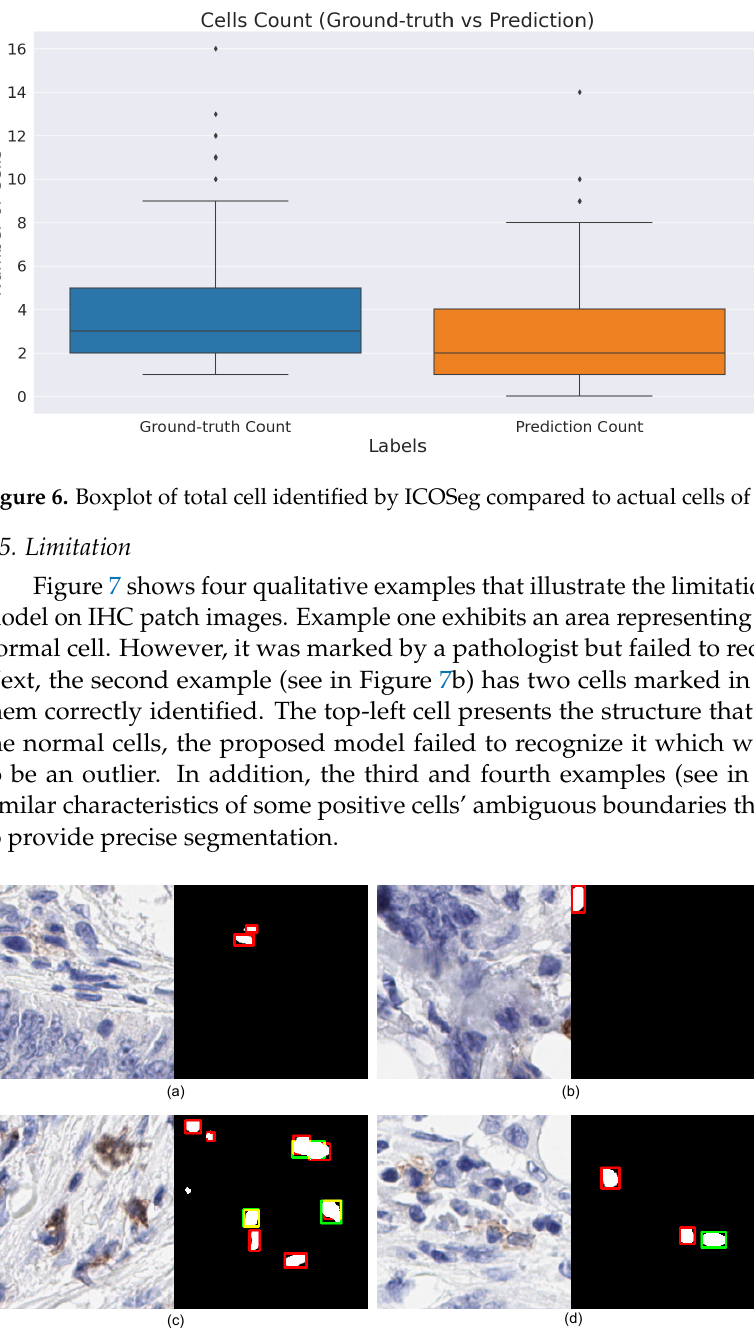
Figure 7. Illustration of four examples shows the limitation of ICOSeg failed to accurately identify and segment the cells boundaries. The red refers to the ground-truth, green corresponds to the ICOSeg prediction and orange/yellow represents the overlap of cell boundary both are common in ground-truth and prediction. The four different examples ( a – d ) refers to the positive cells in